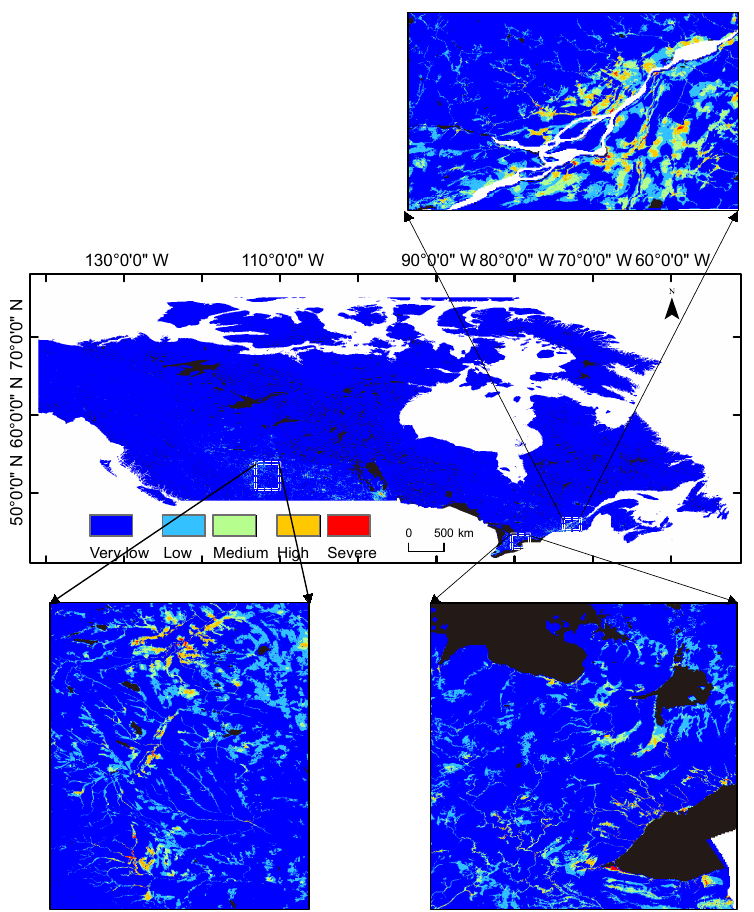
Figure 8. Flood risk map for Canada. Certain portions of the map are enlarged for better visual interpretation of the various levels of flood risk. The risk map is a product of hazard and exposure (flood protection measures are not included). Severe risk only occurs in areas of severe hazard and exposure, causing severe flood risk areas to be concentrated in urban